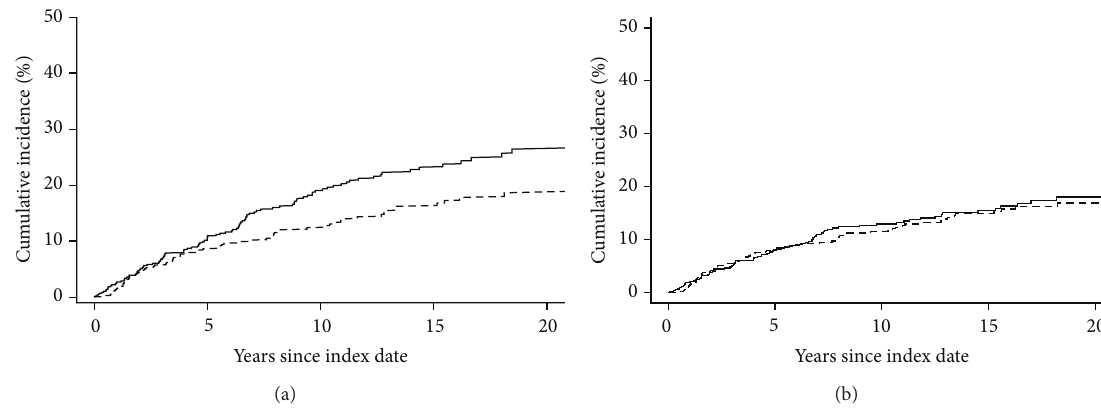
Figure 2: (a) Cumulative incidence of hyperuricemia in patients with rheumatoid arthritis (RA) versus subjects without RA (non-RA). The solid line is RA and dashed line is non-RA ( 𝑃 = 0.008 ). (b) Cumulative incidence of hyperuricemia in patients with RA (based on randomly selected uric acid tests using lower testing rate of the non-RA cohort) versus subjects without RA (non-RA). The solid line is RA and dashed line is non-RA ( 𝑃 = 0.64